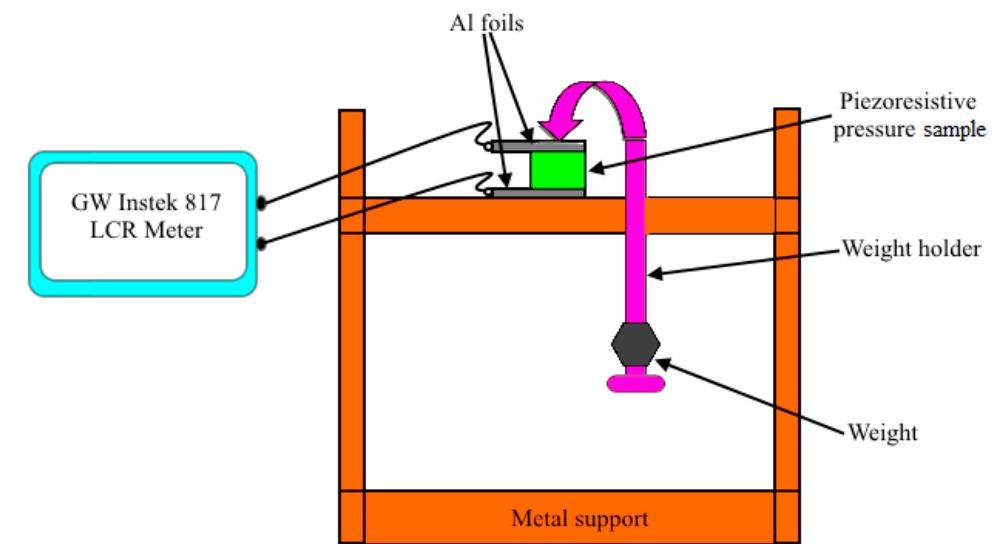
Figure 5. Corresponding schematic of the experimental setup of Figure 4 for the characterization of piezoresistive pressure samples with metallic support, weight holder, weight, sensor, and aluminum foils as terminals connected to a GW Instek 817 LCR meter.